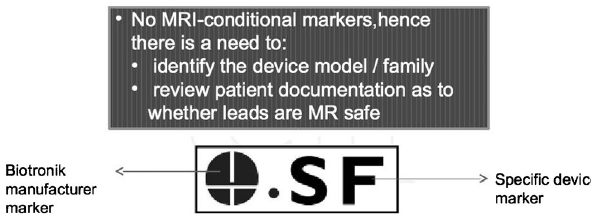
Fig. 8 Enhanced radiographic image of the radiopaque marker for the Biotronik EviaTM device (image used with permission). This device has no specific marker to show that it is MR-conditional; hence, there is a need to identify the device model and